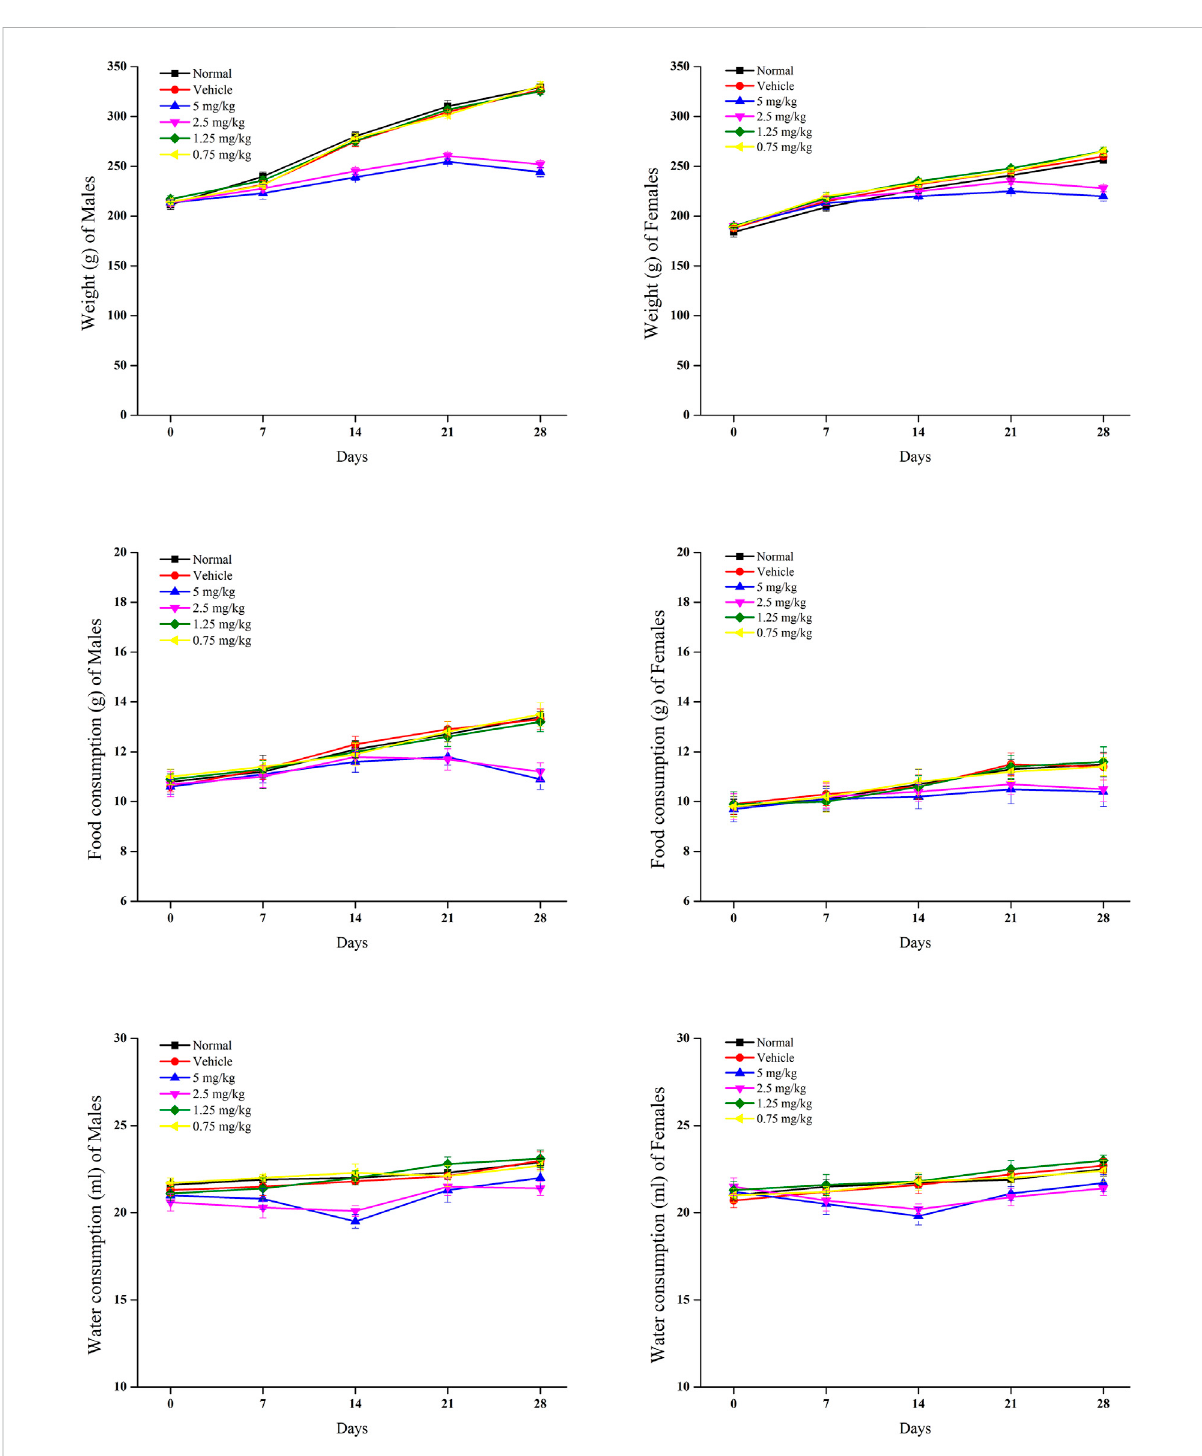
FIGURE 2 Mean food intake, water consumption, and weekly weight gain of rats in 28 days feeding study of